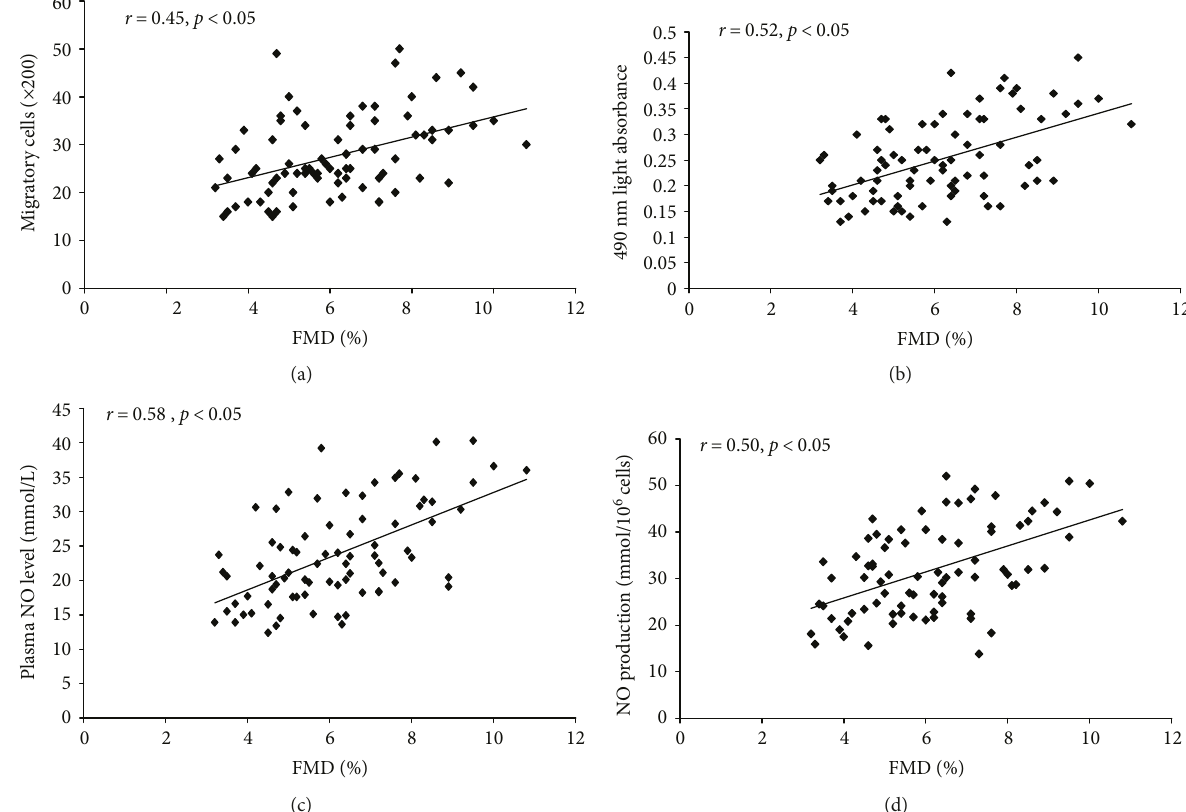
Figure 5: The correlation between the migratory and proliferative capacities of circulating EPCs, and NO level, and FMD was evaluated as follows. There was a correlation between EPC migration (a, b) and FMD. There was also a correlation between the plasma NO level (c) and NO secretion by EPCs (d) and